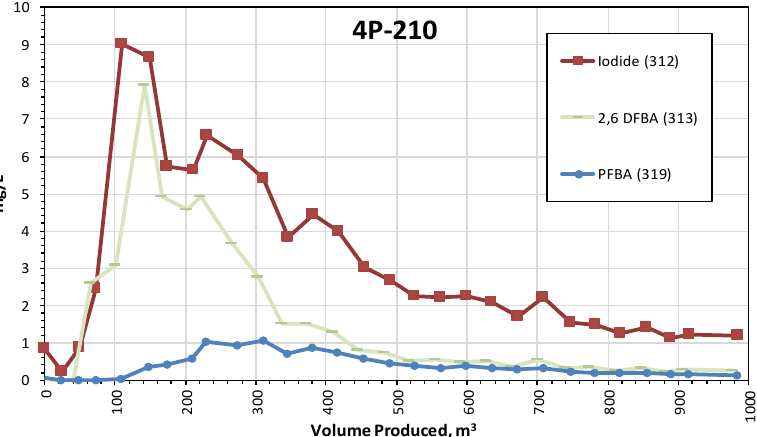
Figure A7. Tracer breakthrough curves as a function of volume produced in well 4P-210. Legend indicates number of the well into which each tracer was injected.